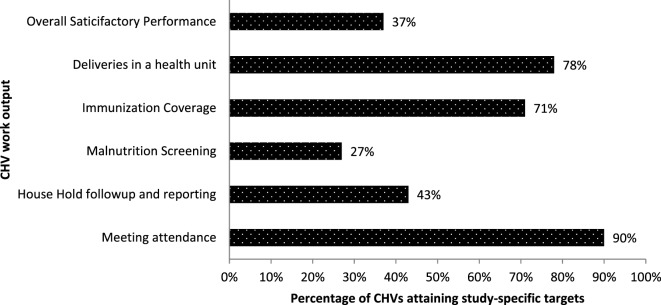
Proportion of CHVs who achieved set targets on work outputs in Bwindi Community Hospital catchment area, Kanungu District, Uganda, 2014–2015 (n = 508). CHV, community health volunteer.